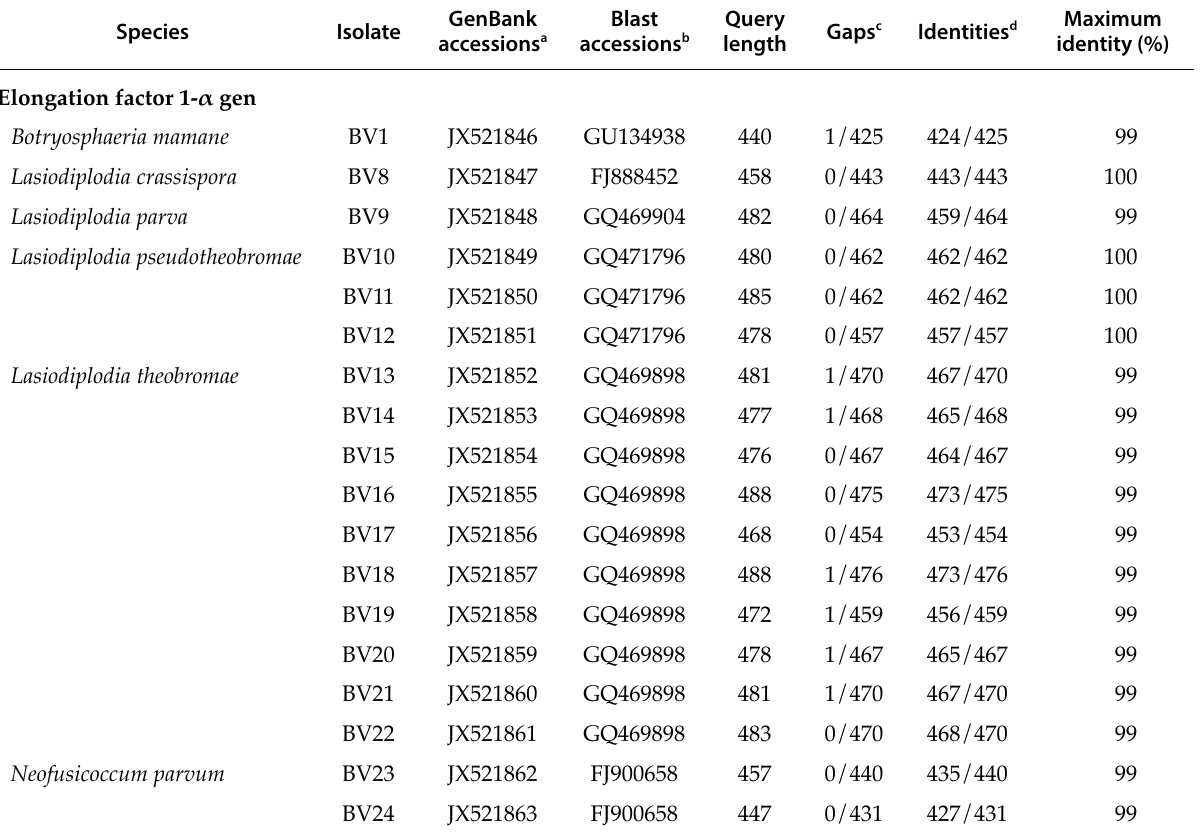
Table 2. List of fungal trunk pathogens isolated from table grapes in Northeastern Brazil, with their corresponding Gen - Bank accession numbers and data of Blast results obtained from